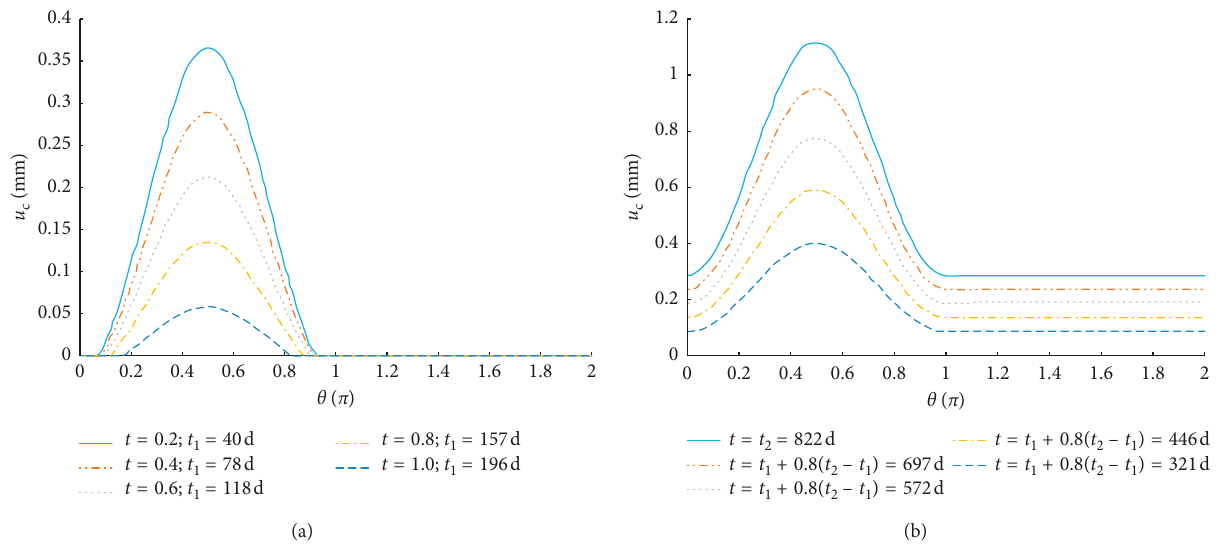
Figure 7: Distribution of concrete radial displacement u